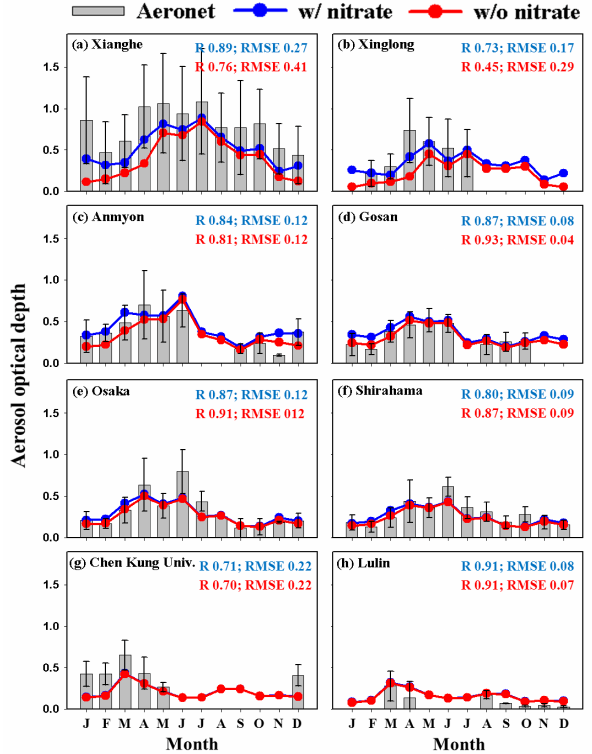
Fig. 10. Comparisons between monthly averaged AERONET AOD (gray bars) and two monthly averaged assimilated AODs with and without NH 4 NO 3 (blue- and red-dotted lines, respectively). The comparisons were made at eight AERONET sites. R and RMSE represent correlation coefficient and root mean square error, respec- tively. RMSEs were introduced together with R , because R is very sensitive to the number of data and is not very reliable in the case of the number of data being small. The black bars indicate ± σ (stan- dard deviation) calculated from the daily AERONET AOD data. All the comparisons were made under clear-sky